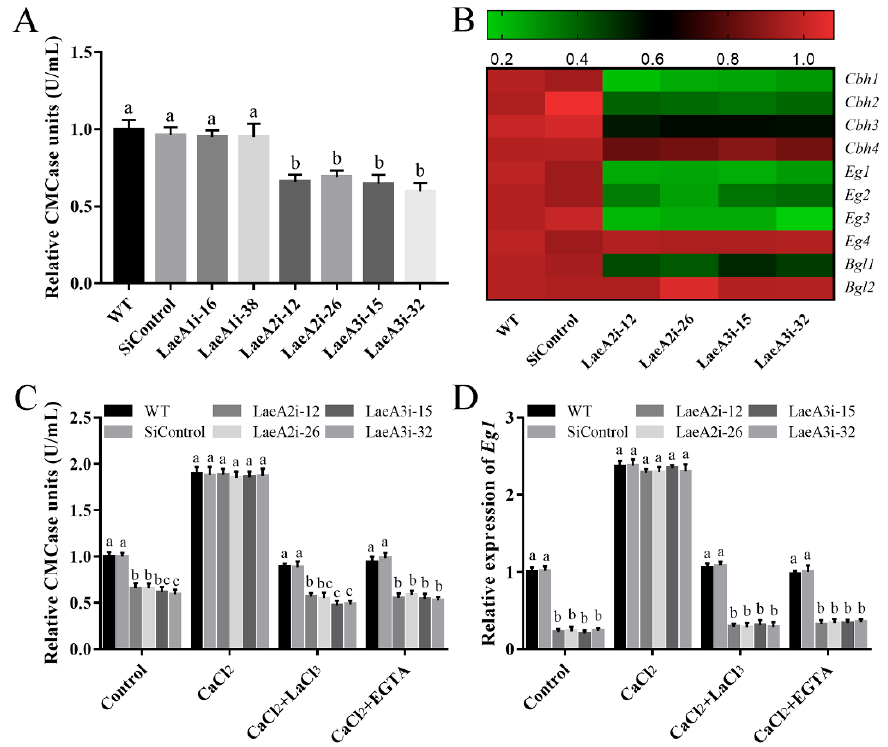
Figure 8. The cytosolic Ca 2+ content was involved in the regulation of cellulase activity by PoLaeA2 and PoLaeA3 . The P. ostreatus strains cultured in liquid CYM at 28 °C for 5 days were transferred into MCM using cellulose as the sole carbon source, and treated with 5 mM CaCl 2 , LaCl 3 or EGTA for 24 h. ( A ) CMCase (endoglucanase) activities of the PoLaeA -silenced strains. ( B ) Relative expression of the cellulase genes. The expression levels of the cellulase genes in the WT strain were arbitrarily set to 1.0. ( C ) CaCl 2 recovered the decreased CMCase activities in the PoLaeA2 - and PoLaeA3 -silenced strains. ( D ) Transcriptional analysis of Eg1 . The values are the mean ± SD ( n = 3). Different lowercase letters indicate significant differences between the strains ( p < 0.05, according to Dunnett’s multiple comparisons test).